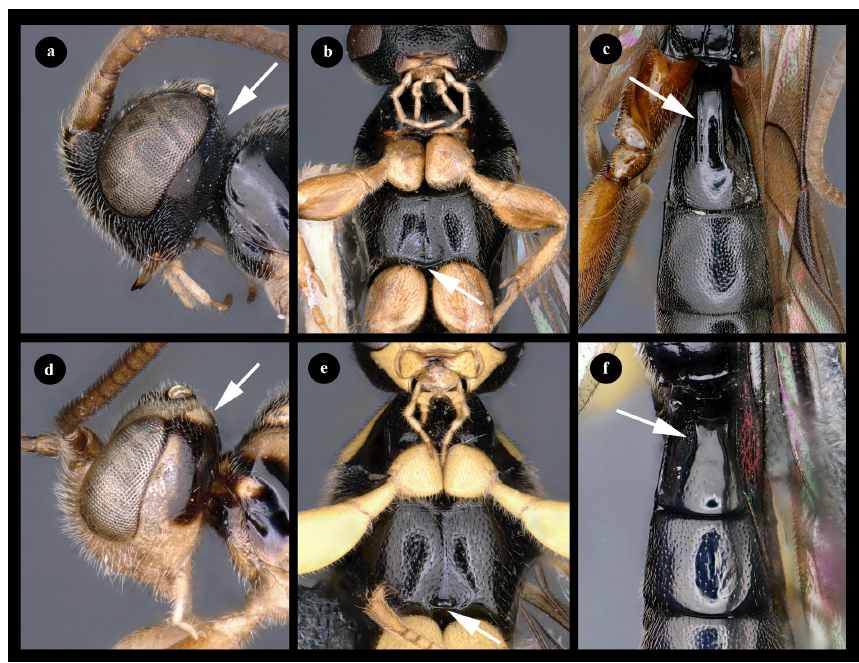
Fig. 12. a–c . Hypsicera sp. a . Head, lateral view. b . Mesosoma, ventral view. c . Metasomal tergite 1, dorsal view. d–f . Exochus sp. d . Head, lateral view. e . Mesosoma, ventral view. f . Metasomal tergite 1, dorsal view. Arrow in Fig. 12a points to vertical occiput (compared to rounded occiput in Fig. 12d). Arrow in Fig. 12b points to posterior transverse carina on mesosternum convex medio-posteriorly (compared to straight posterior transverse carina on mesosternum in Fig. 12e). Arrow in Fig. 12c points to the long lateromedial carina on first metasomal tergite (compared to the short lateromedial carina on first metasomal tergite in Fig.